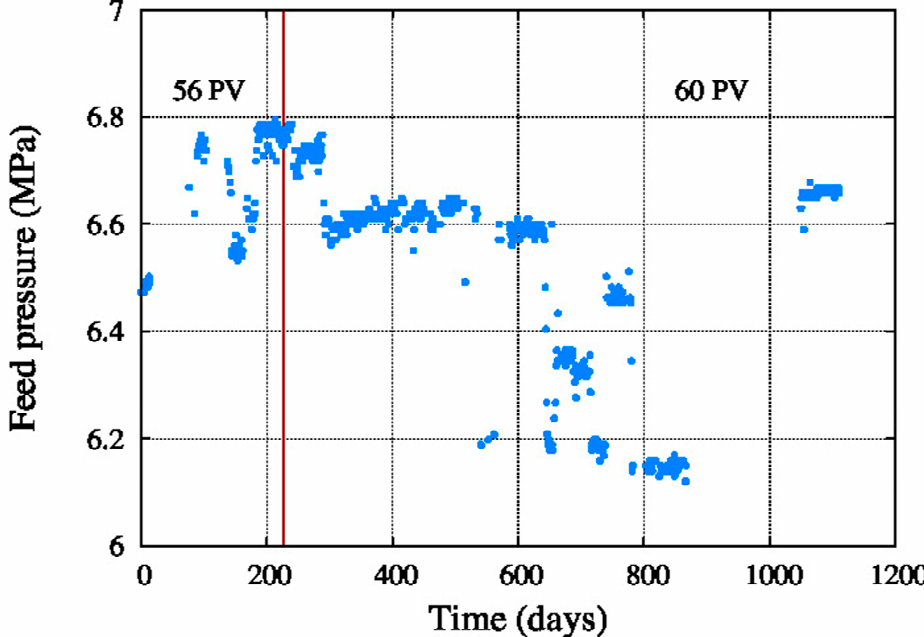
Figure 3. Feed pressure. Figure 3. Feed